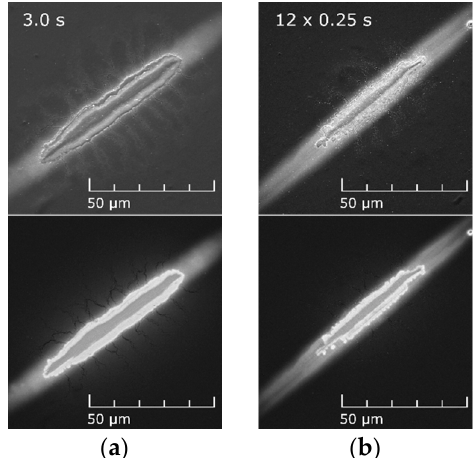
Figure 10. SEM micrographs of free metal wires treated for ( a ) 1 s ( b ), 2 s ( c ) and 3 s at distance H = 0.3 mm. Top row—SE image; bottom row—BSE image.